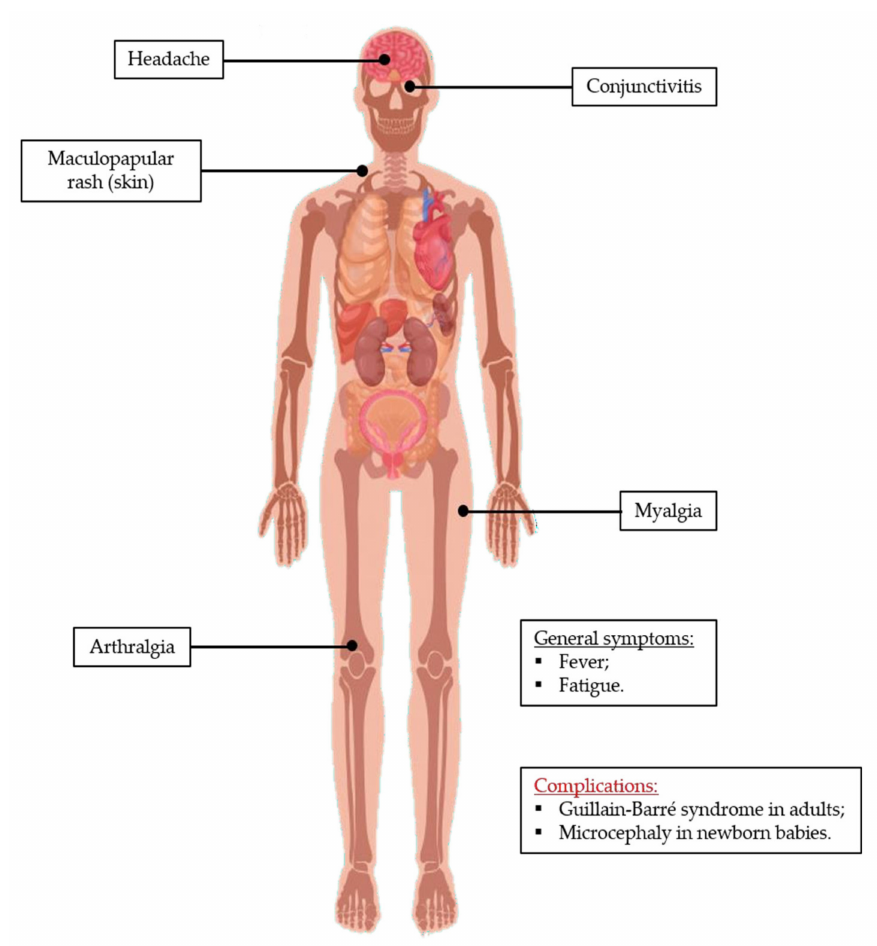
Figure 6. Zika infection clinical symptoms. The typical clinical manifestations of Zika include flu-like symptoms, namely headache, fever, and fatigue. Myalgia, arthralgia, and conjunctivitis are also commonly observed symptoms. However, the most serious complications are the development of Guillain-Barr é syndrome in adults and microcephalia in newborn babies, which are devastating consequences of Zika infection. This image has been designed using resources from